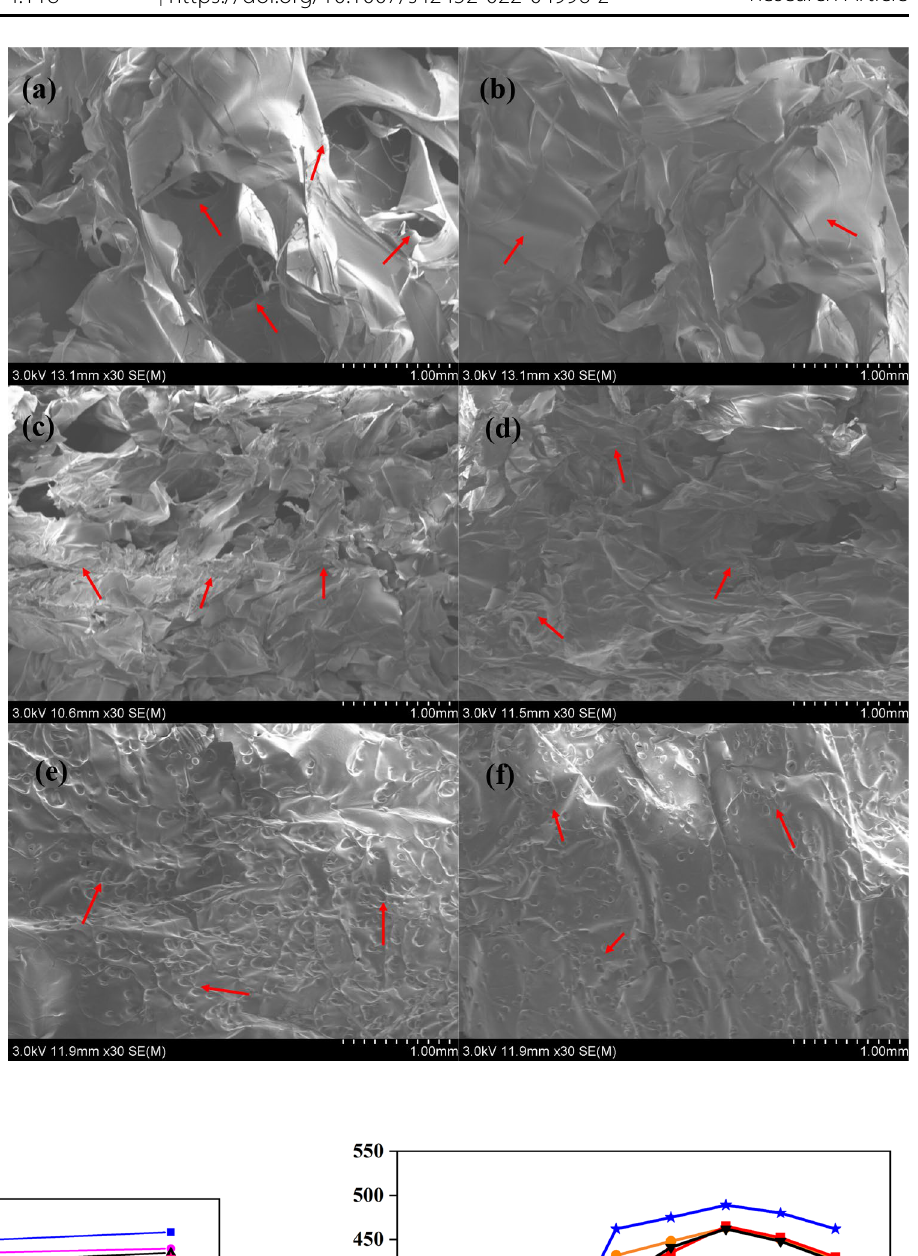
Fig. 3 SEM images of PAA/ PAM/[DMAEMA]MA hydrogels processed by freeze drying ( a, b ); SEM images of PAA/